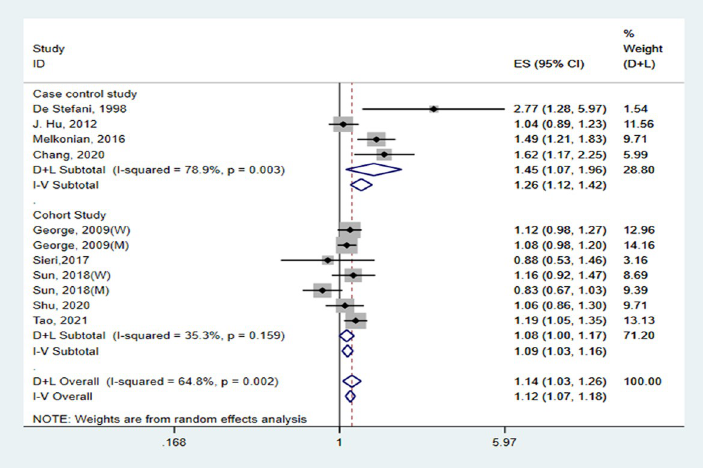
Fig 2. Forest plot showing risk estimates of the association between GI and lung cancer risk.